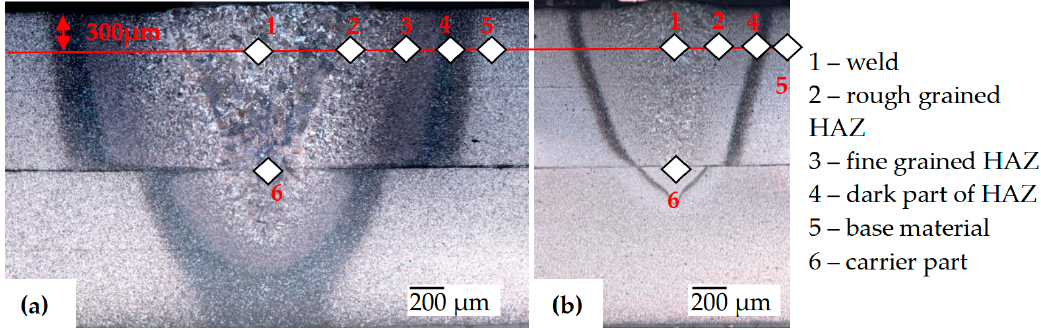
Figure 2. Mascrosection of the weld with schematic presentation of hardness measurement positions: ( a ) 0.3 m/min, ( b ) 0.8 m/min.